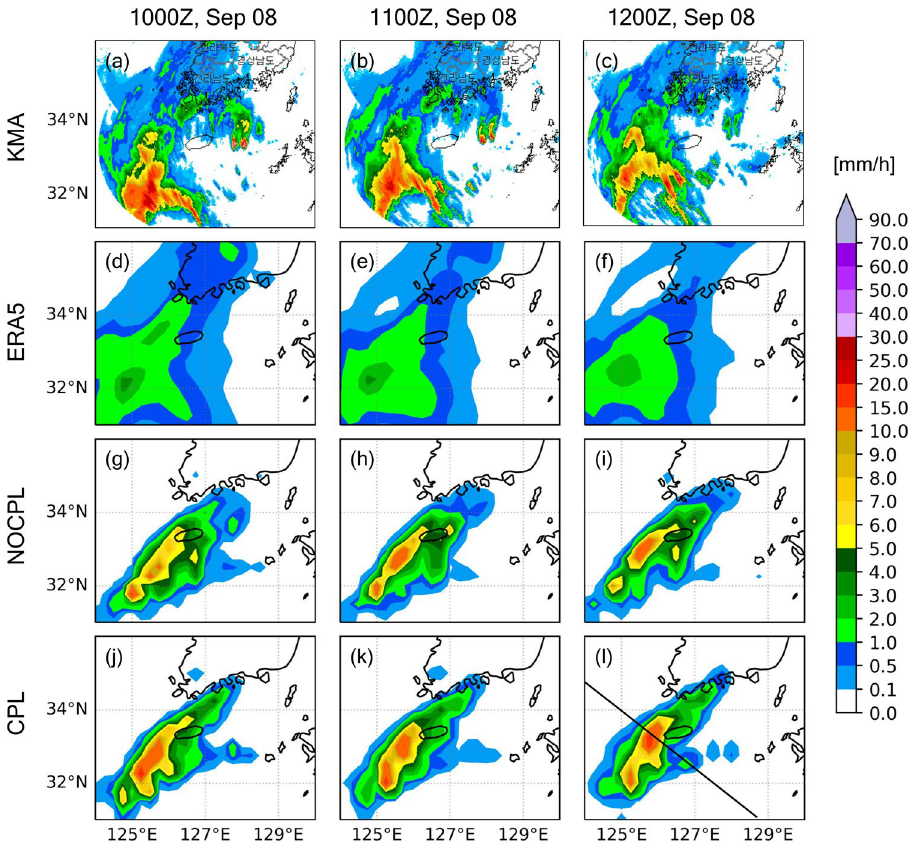
Figure 10. Horizontal distribution of 1 h cumulative precipitation (mm/h; shaded) for ( a – c ) Korea Meteorological Administration (KMA) weather radar, ( d – f ) ERA5, ( g – i ) NOCPL, and ( j – l ) CPL every 1 h. The solid black line on the lower-right panel ( l ) is the reference line for the cross-section of Fig.